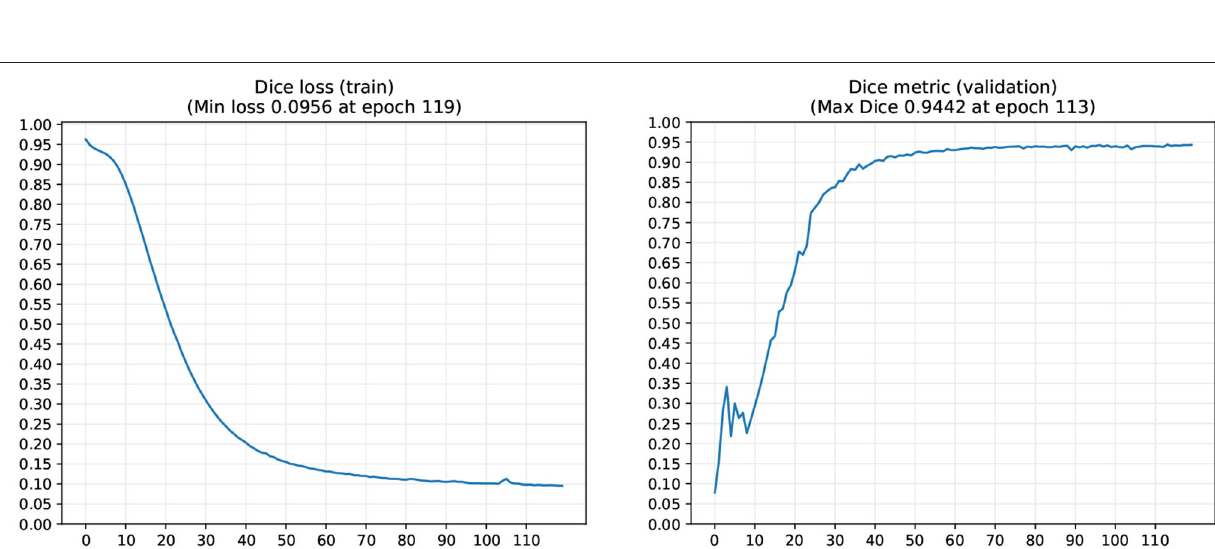
Frontiers in Neurology |